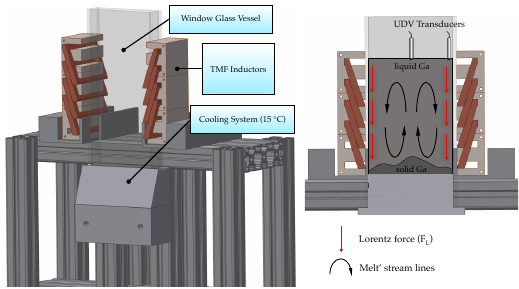
Figure 3. Experimental setup of solidification process in presence of travelling magnetic field from Reference